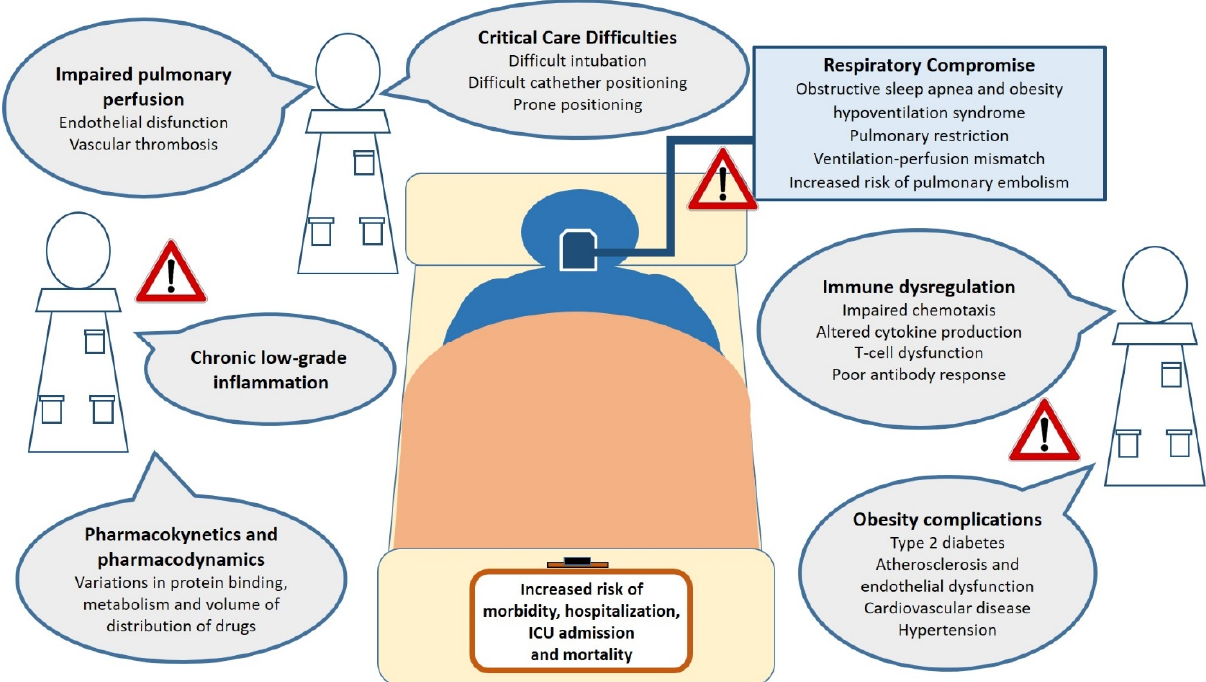
Figure 1. Obesity-related factors associated to adverse clinical outcomes from viral infections in both specialty and intensive care settings. Potential mechanisms by which obesity may augment the risk of critical illness and death from viral infections. These include chronic inflammation, impairment of respiratory function and pulmonary perfusion, critical care management difficulties, immune dysfunction, metabolic and cardiovascular complications of obesity. Abbreviations: ICU, intensive care unit.